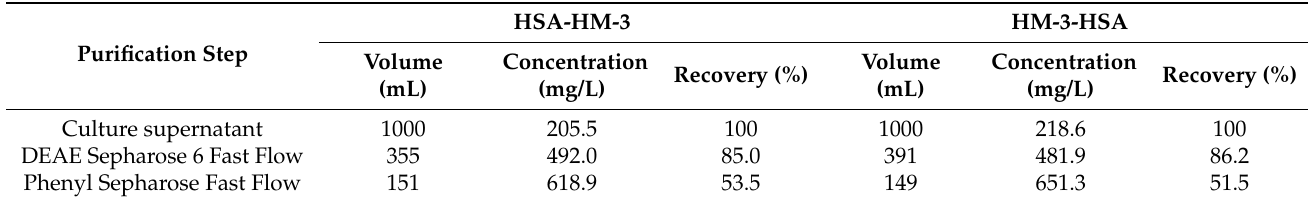
Table 1. Purification process and recovery of HM-3/HSA.